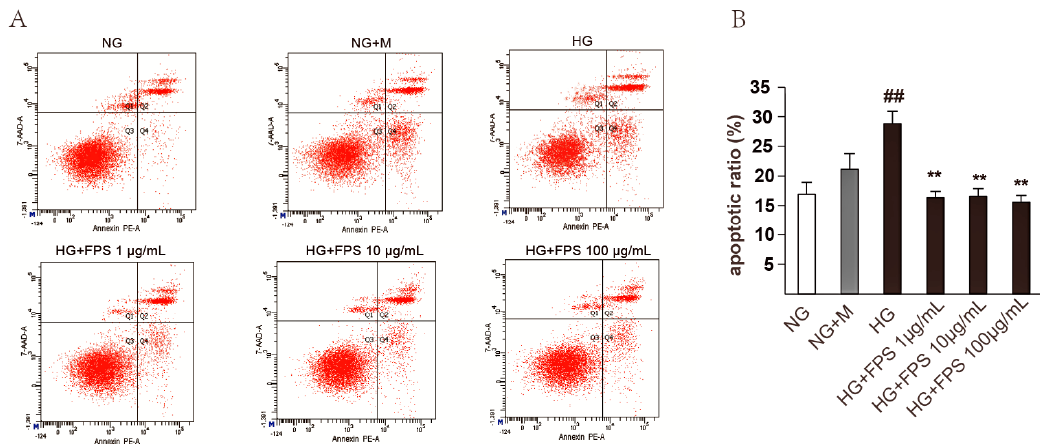
Figure 7. The effects of FPS on antiapoptotic in injured RSC96 Cells: ( A ) Annexin V-PE and 7-AAD